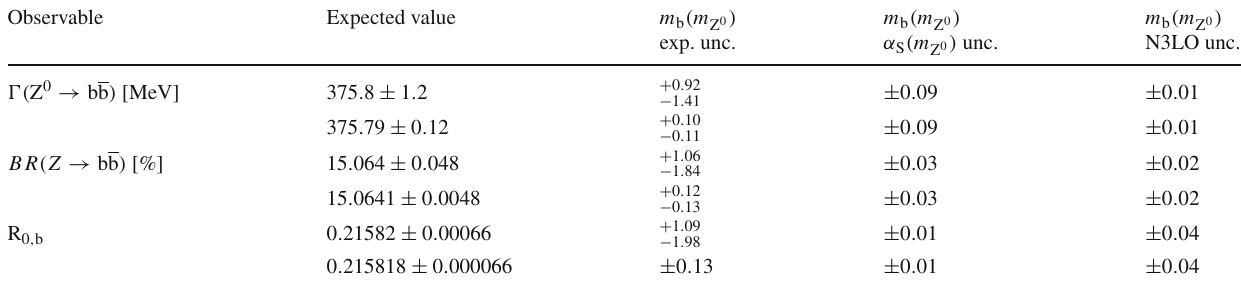
Table 1 Results for m b ( m Z 0 ) uncertainties [GeV] with Gfitter for the three observables with either the actual uncertainties from LEP and SLD or uncertainties reduced by a factor 1/10. m b ( m Z 0 ) = 2 . 88 GeV is used in all